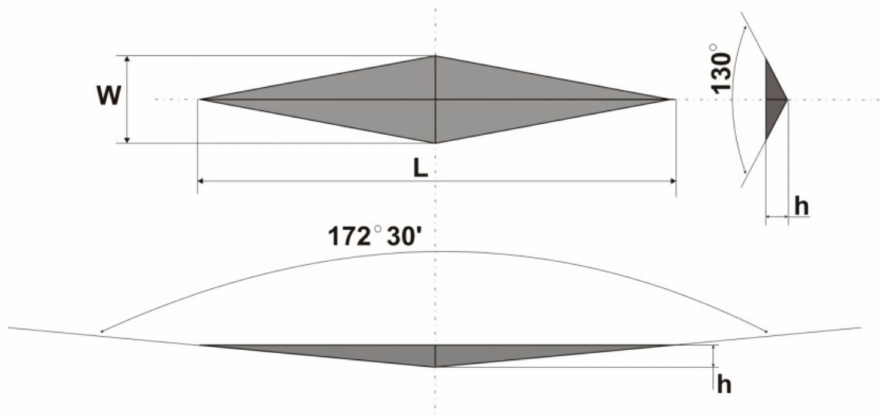
Figure 2. The image of an indentation left by the Knoop